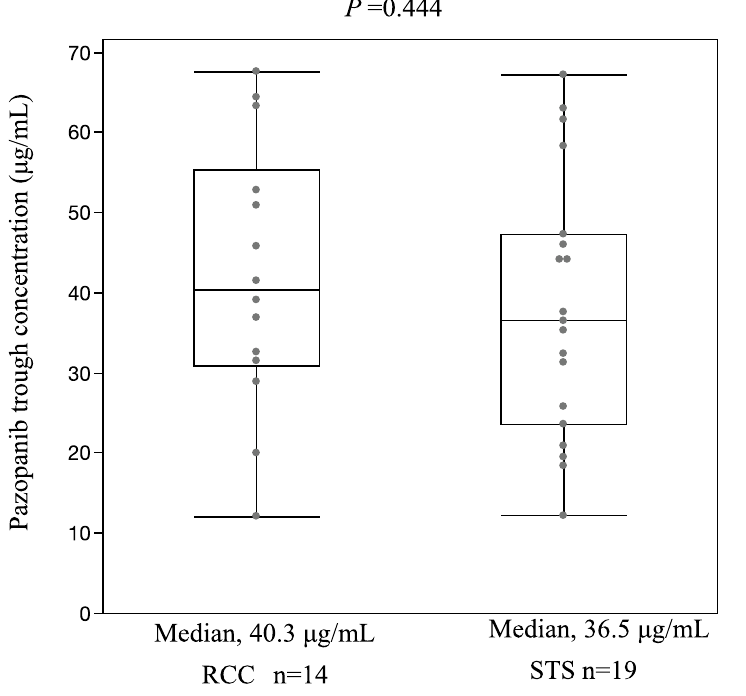
Figure 2. Association of pazopanib plasma trough concentrations with antacid administration in patients with renal cell carcinoma and soft tissue carcinoma. Statistical tests were compared using a Mann–Whitney U test (two-sided).